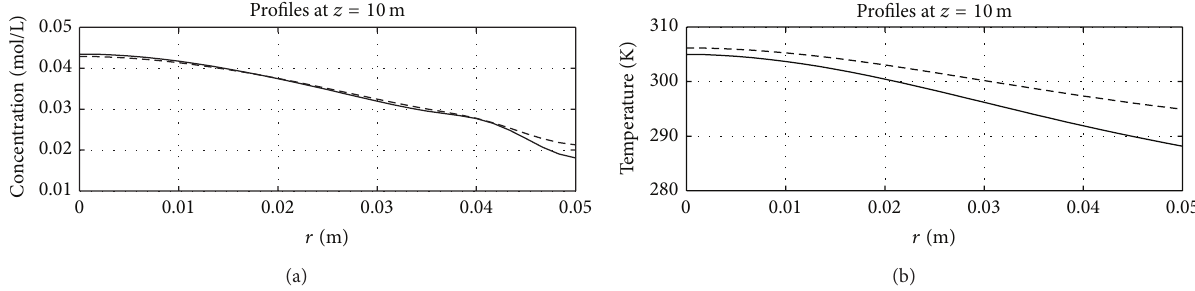
Figure 11: Steady state temperature and concentration profiles for Test 1 at 𝑧 = 10 m. Solid line—MPC. Dashed line—nominal profile (reference).